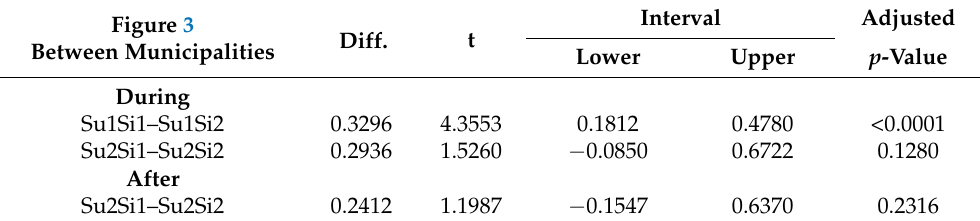
gender differences. Table A3. Hypothesis tests of means corresponding to Figure 4. Data panels in the same order than in the figure. Interval Adjusted Figure 4 Upper Diff. t Between Surveys Lower Upper p -Value Before Si1W–Si1W − 0.6131 Si2W–Si2W − 0.1725 During